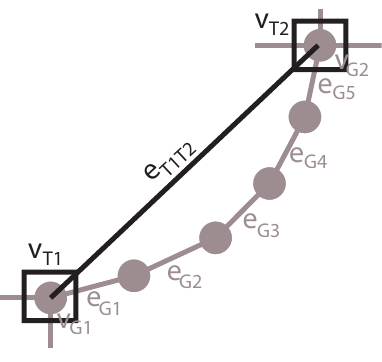
Figure 2: Illustration of how topology abstracts from geometry. The topological edge e T 1 T 2 abstracts from the fi ve geometric edges e G 1 to e G 5